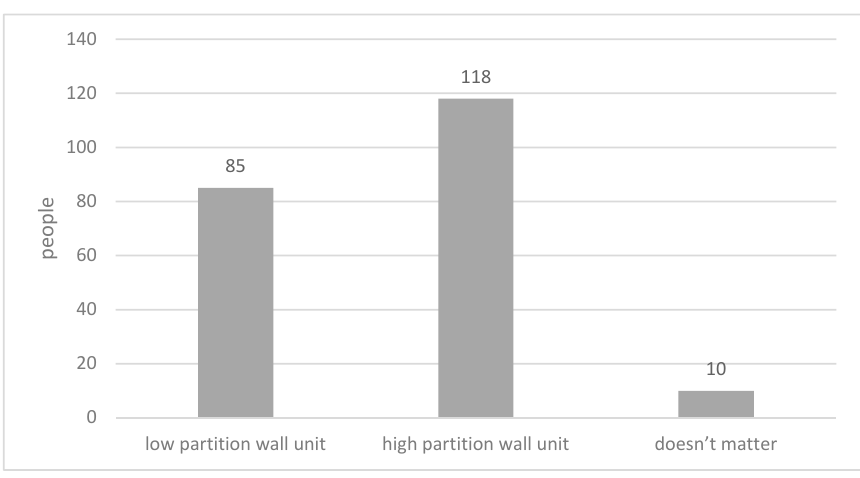
Figure 8. Preferred room types with age group.